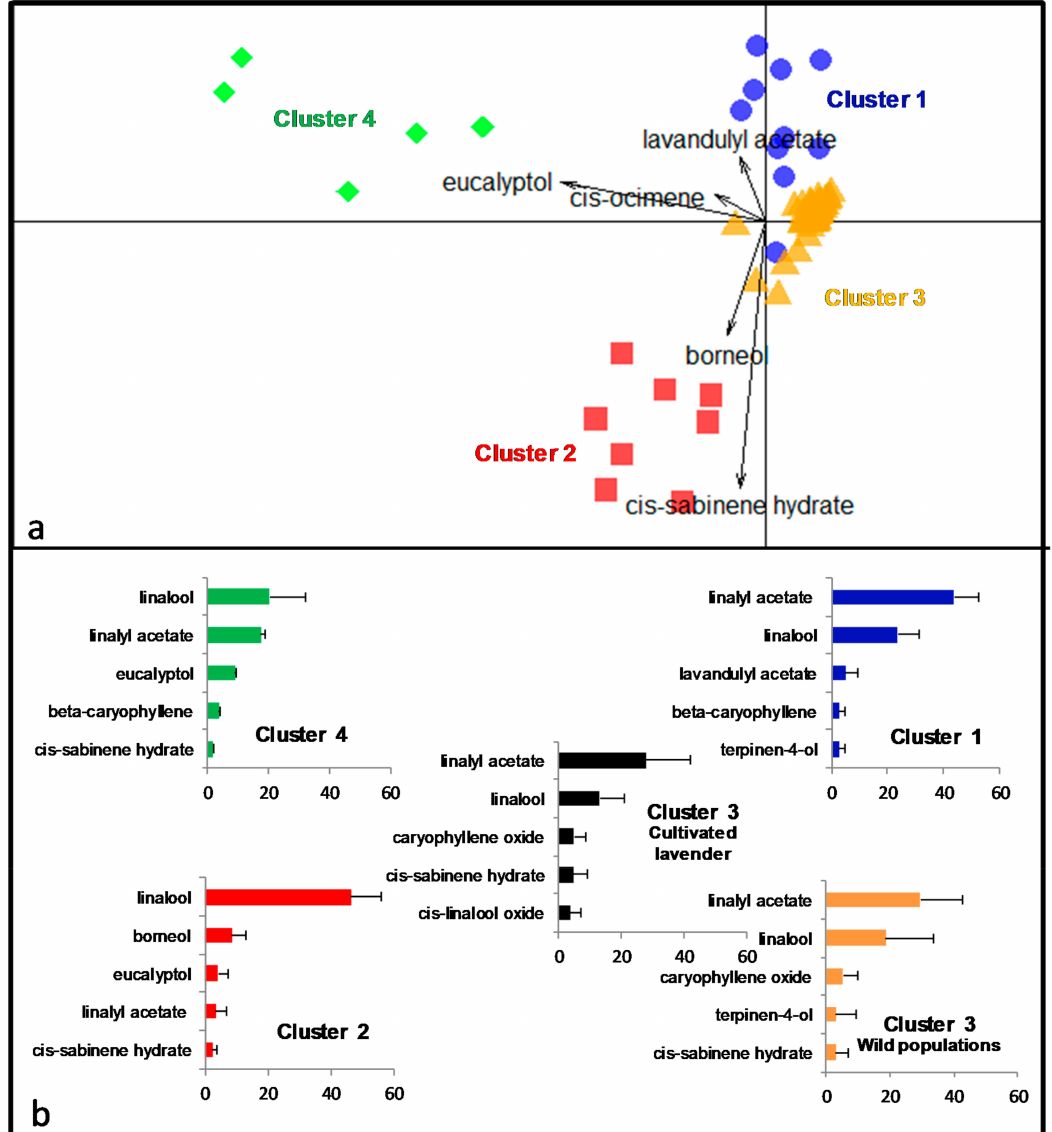
Figure 4. ( a ) Discriminant analysis based on the chemical composition of 90 individuals from 14 wild sampled sites and 5 cultivated fields of lavender (N cluster1 = 12; N cluster2 = 8; N cluster3 = 65; N cluster4 = 5). The arrows indicate the most discriminant compounds. The di ff erent symbols materialized the 4 clusters identified by DAPC. ( b ) For each cluster, the mean percentage of the total amount ± SD for the five major compounds is represented. For cluster 3, the composition of wild (N = 40) and cultivated (N = 25) populations are